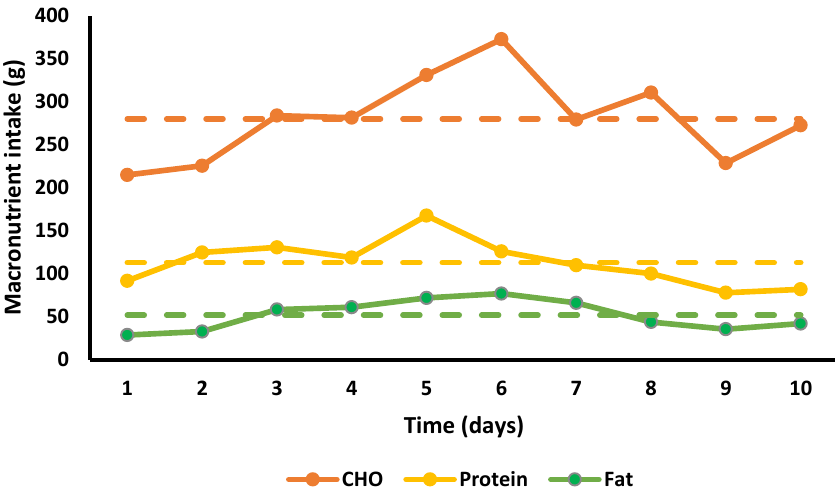
Figure 2. Daily macronutrient intake in grams per kg body mass. Bars represent individual macro- nutrient intake per day; dashed lines correspond to mean intake for each macronutrient.